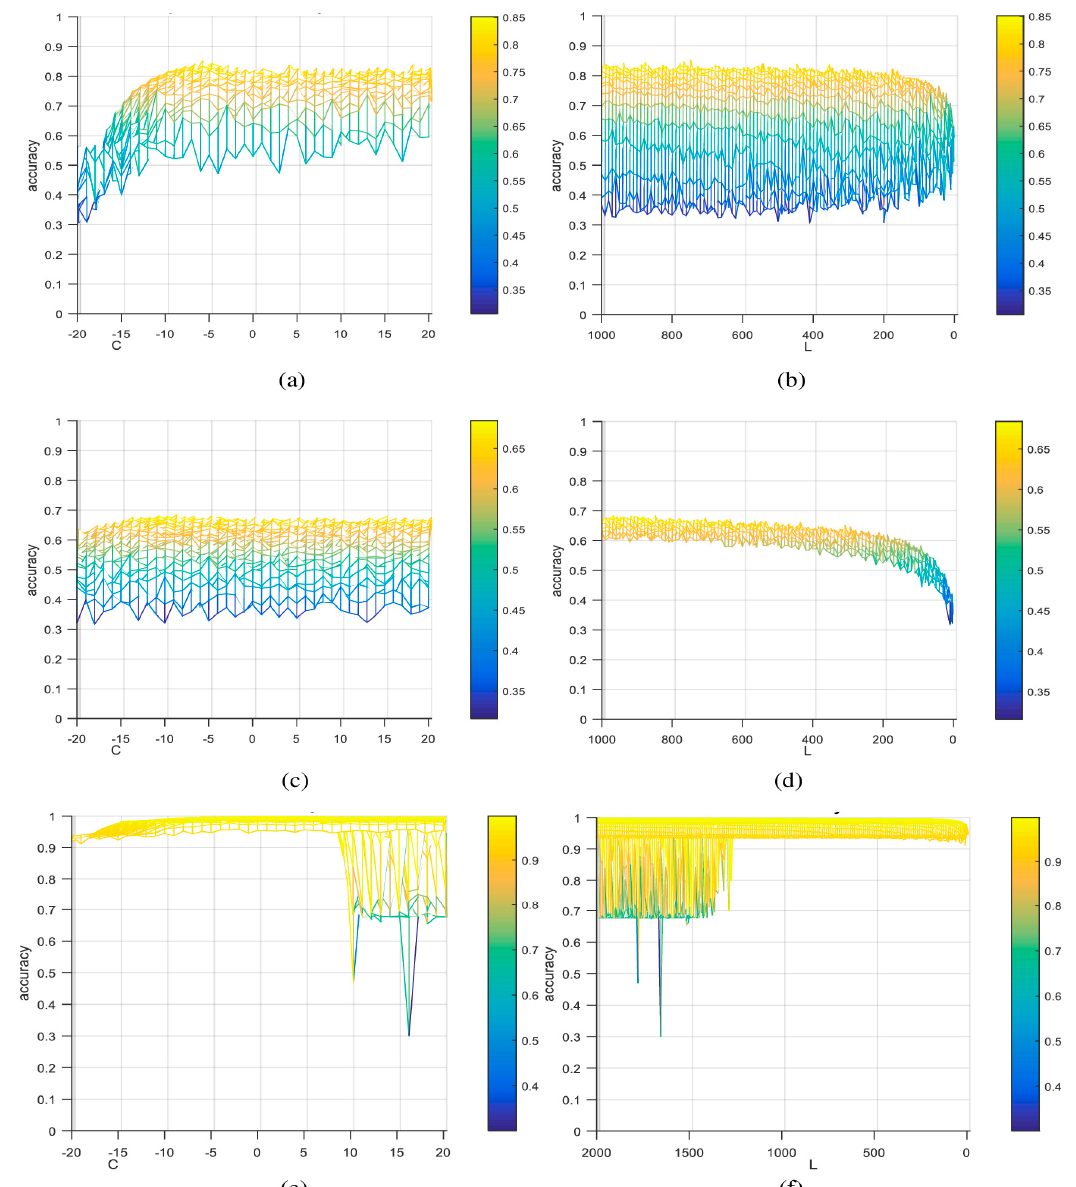
Figure 5. Projections of the mesh on accuracy vs. regularization factor, and accuracy vs. number of neurons in hidden layers for the three datasets TampereU, UJIIndoorLoc, and KDD99. ( a ) Mesh representation of the relation between the accuracy, L, and C for ELM classifier based on TampereU dataset ( b ) relation between the accuracy and C for ELM classifier based on TampereU dataset. ( c ) relation between the accuracy and L for ELM classifier based on TampereU dataset. ( d ) relation between the accuracy, L, and C for ELM classifier based on UJIIndoorLoc dataset. ( e ) relation between the accuracy and C for ELM classifier based on UJIIndoorLoc dataset. ( f ) relation between the accuracy and L for ELM classifier based on UJIIndoorLoc dataset.